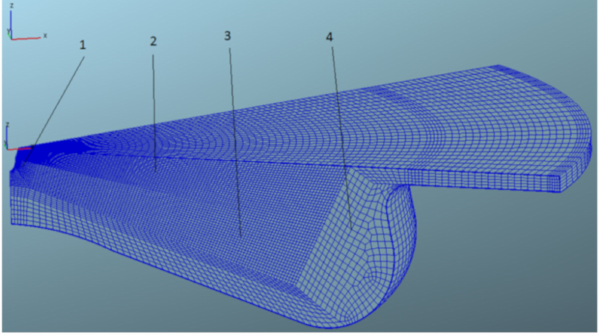
Figure 1. Mesh used in CFD